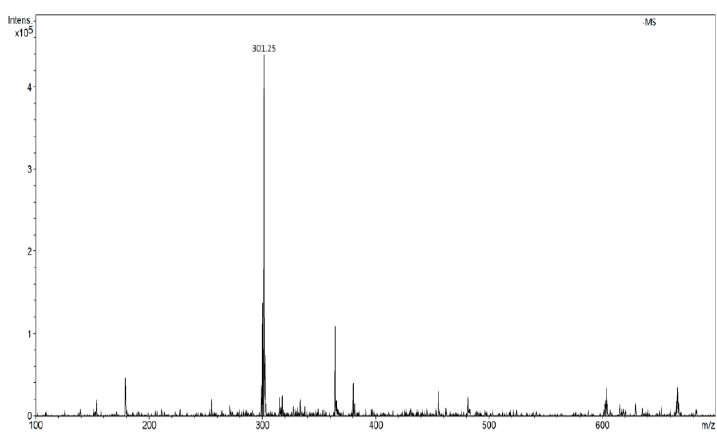
Figure 4. FAPA spectrum of quercetin in the ranges of negative ions ( m/z 301 [M − H] − ).